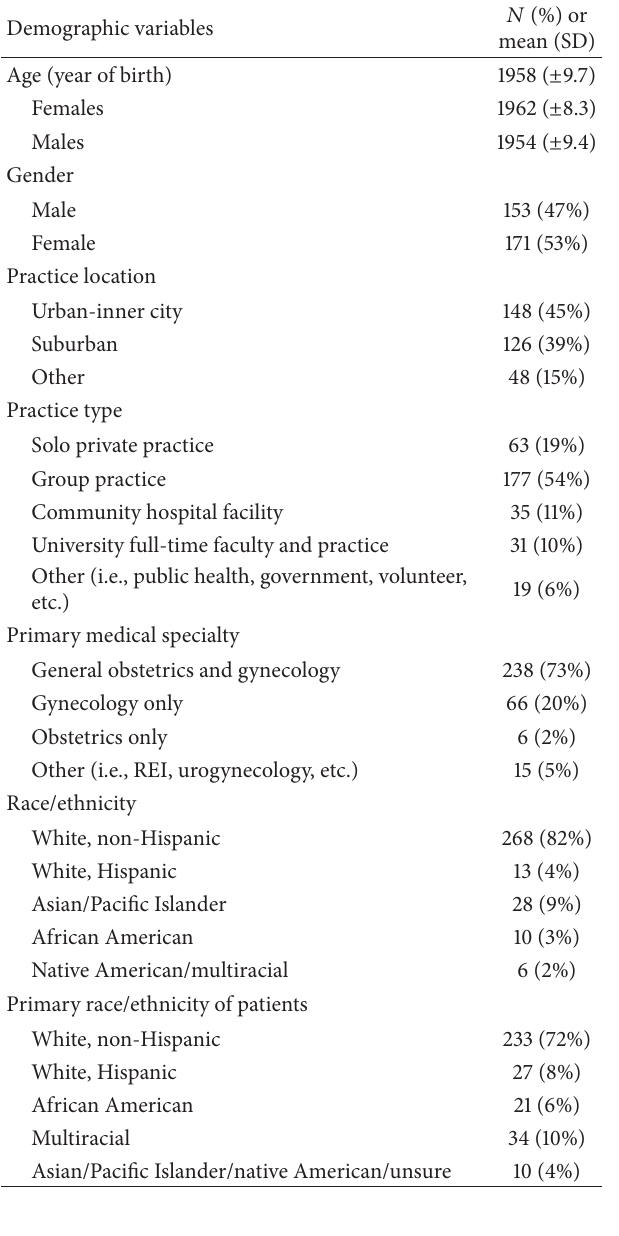
Table 1: Demographic variables of responding physicians ( 𝑁 = 327 ).